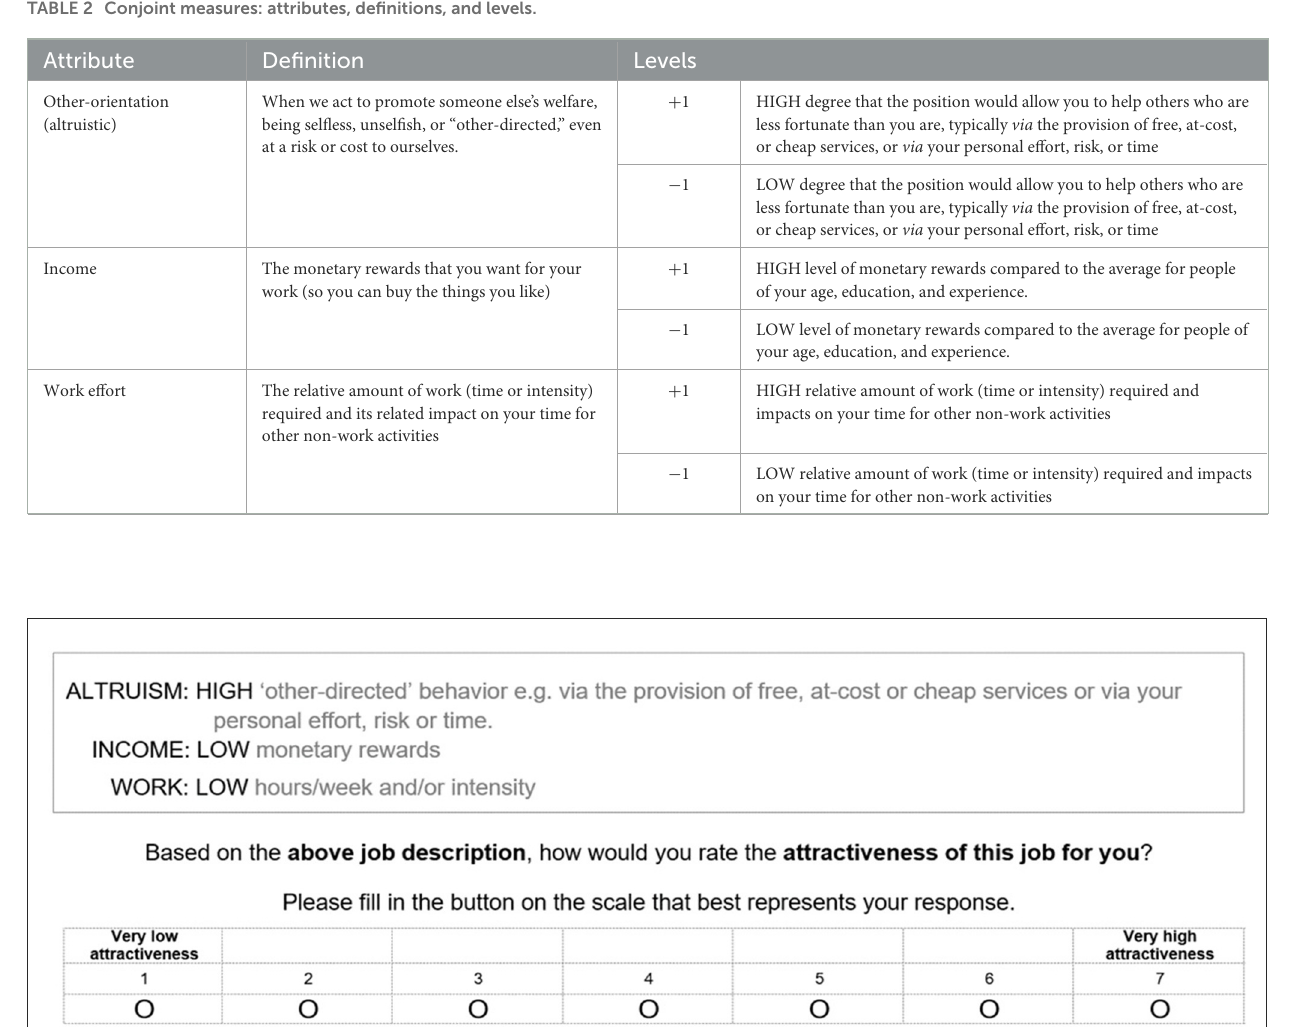
TABLE 2 Conjoint measures: attributes, definitions, and levels.